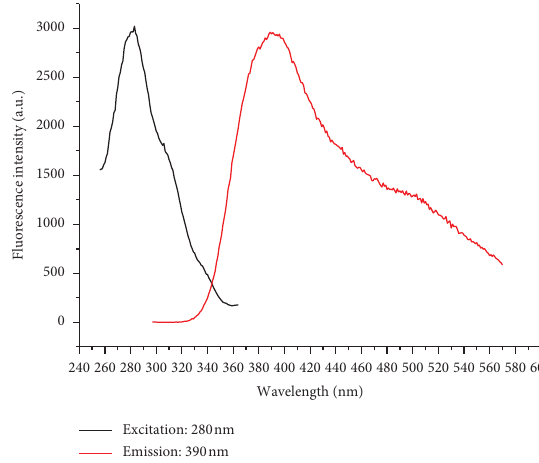
Figure 1: Fluorescence spectra of DNA-Cu NPs.